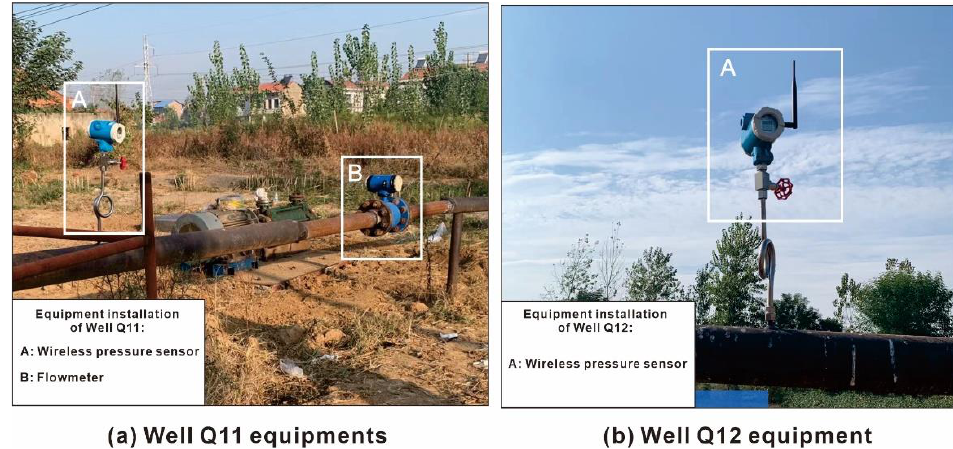
Figure 11. Brine Injection Testing site.